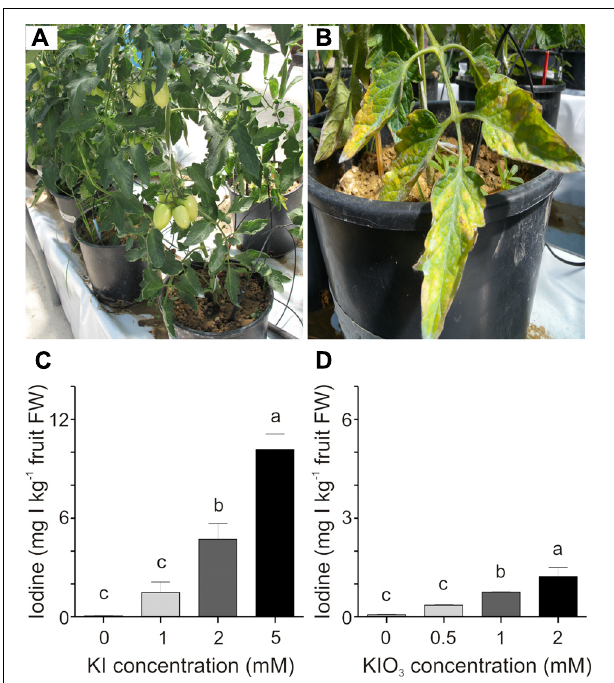
FIGURE 2 | Effect of iodine dose and form on iodine uptake and accumulation. Healthy iodine-treated plants at the end of the experiment (A) . 5 mM KI-treated plants showed some phytotoxicity symptoms on the basal leaves (B) . Iodine uptake in fruits collected from the second truss of (C) KI- and (D) KIO 3 -treated plants, after four weekly iodine applications. Data were subjected to one-way analysis of variance (ANOVA) and the means were separated using the F -test (95% confidence level).